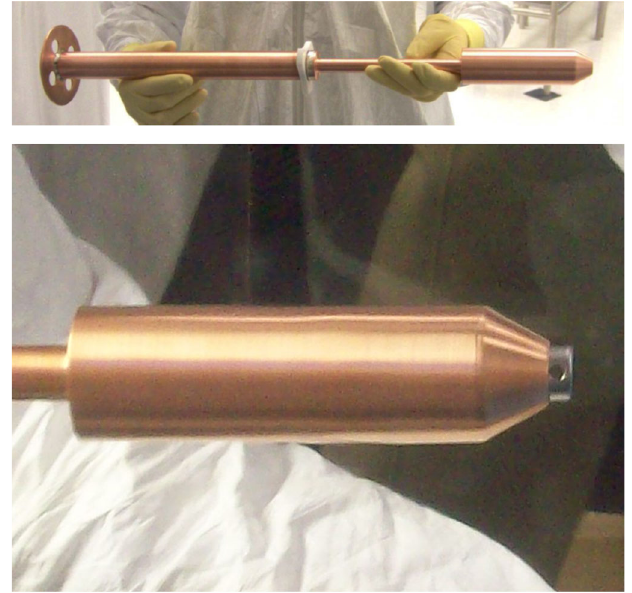
FIG. 4. Top: cathode stalk without an installed cathode. Bottom: detail of installed cathode.